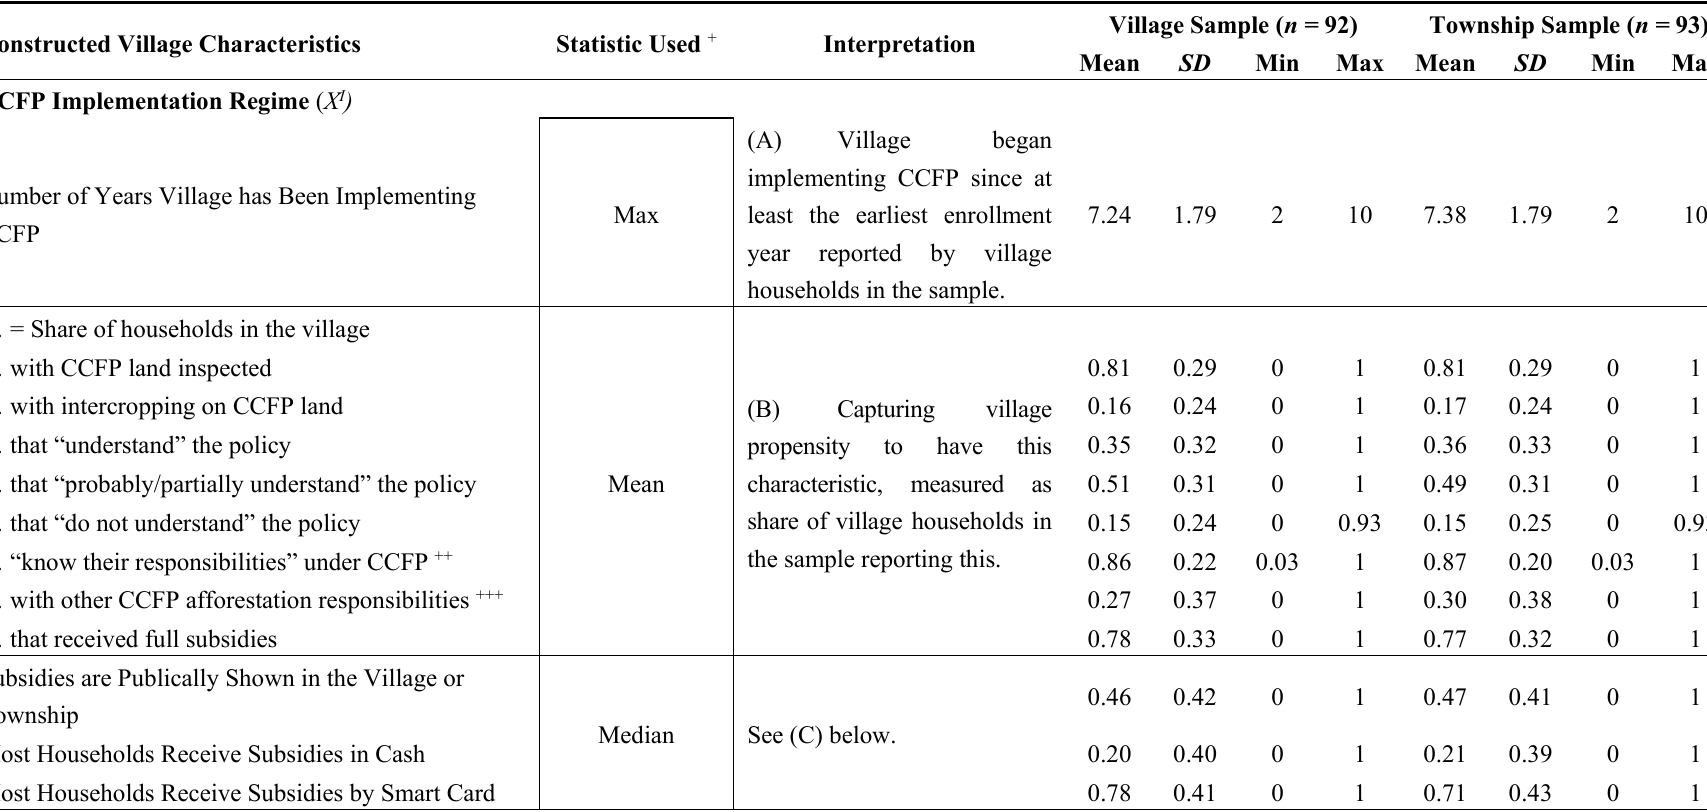
Table 3. Explanatory variables—constructed village institutional, conversion of cropland to forests program implementation and other characteristics,